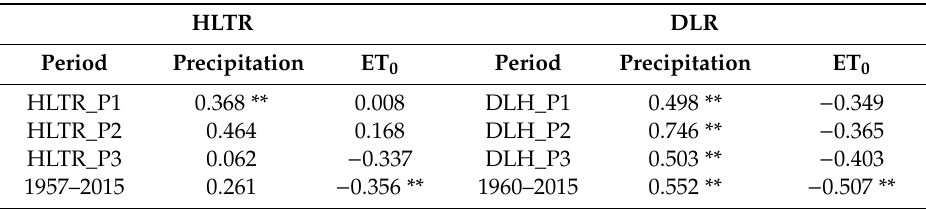
Table 4. Correlation between annual amount of baseflow, precipitation and reference vapotranspiration in di ff erent periods in two watersheds. HLTR DLR Period Precipitation ET 0 Period Precipitation ET 0 HLTR_P1 0.368 ** 0.008 DLH_P1 0.498 ** − 0.349 HLTR_P2 0.464 0.168 DLH_P2 0.746 **